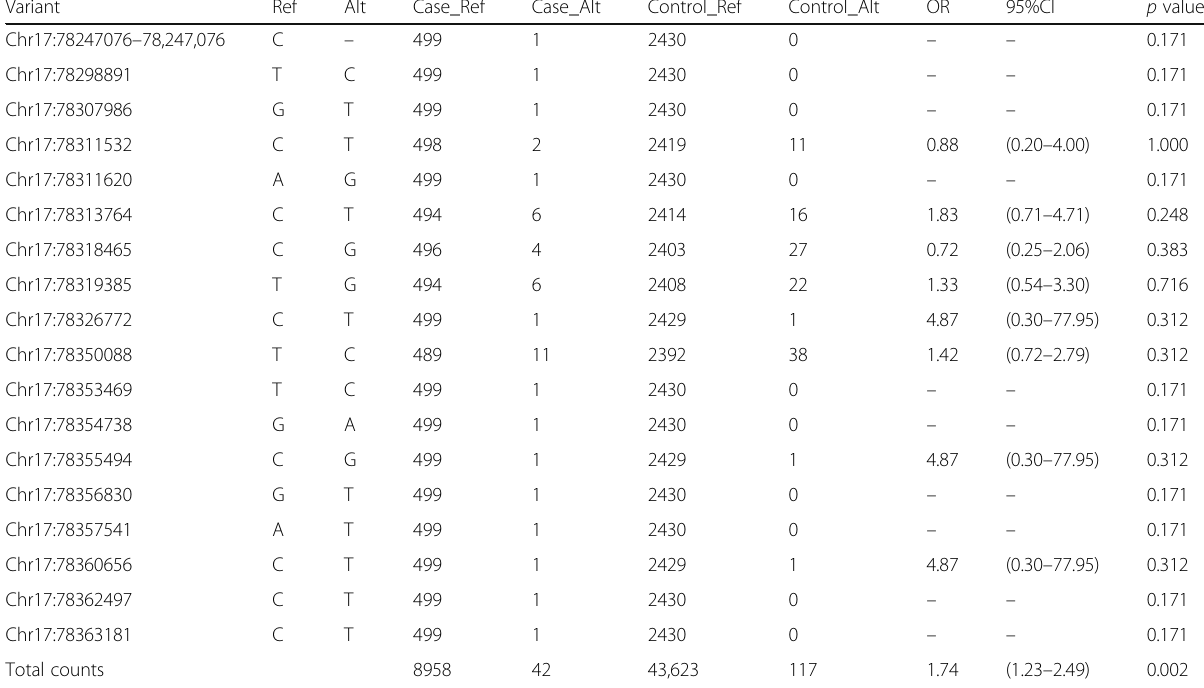
Table 4 Single variant test and cumulative allele odds ratio of RNF213 rare variants